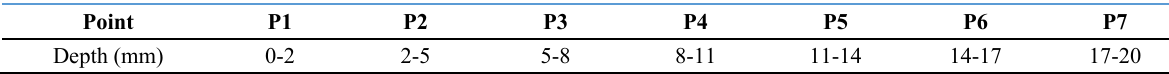
Table 4. Extraction depths to determine chloride